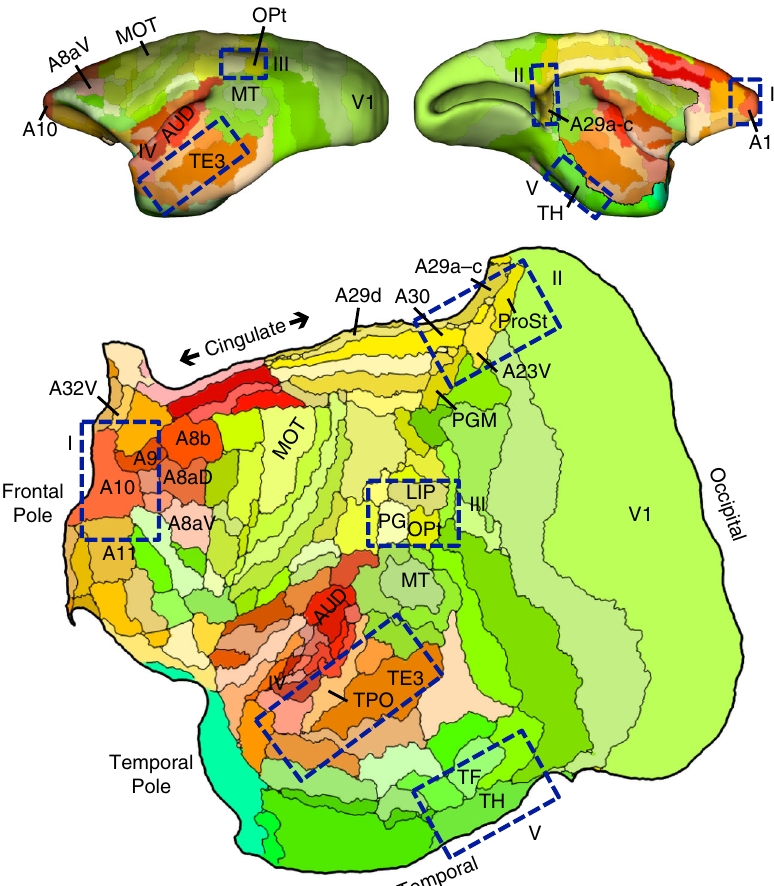
Fig. 1 Flat map format and candidate zones of interest. All cortical areas are displayed on a fl at map that minimizes distortion 58 . The lateral (top left) and midline (top right) show the volume surface models of the marmoset cortex color-coded corresponding to the fl at map representation below. Relevant areas are labeled for orientation as well as MOT (primary motor cortex A4ab) and AUD (auditory cortex involving multiple primary auditory areas). The major zones of interest in this paper are highlighted by blue rectangles: (I) frontopolar A10, (II) posterior midline A29a – c, A23, caudal A30, (III) rostral temporal association cortex TE3/TPO/PGa/IPa, (IV) posterior parietal cortex Opt/PG, and (IV) parahippocampal cortex TH/TF. These are not the only zones implicated in the default network but represent fi ve zones that are candidate homologs to several of the well-studied regions implicated in default network-A in the human 23 . Area labels use nomenclature of the Paxinos et al. 49